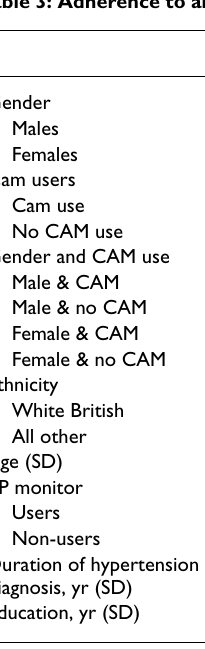
Table 3: Adherence to anti-hypertensive medication